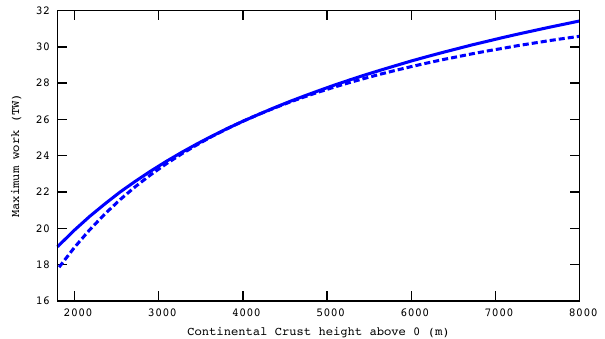
Fig. 13. Sensitivity of oceanic crust recycling rate to continental crust thickness. Solutions assuming non-adaptive crust recycling are shown with a dashed line, solutions assuming adaptive crust recycling are shown with a solid